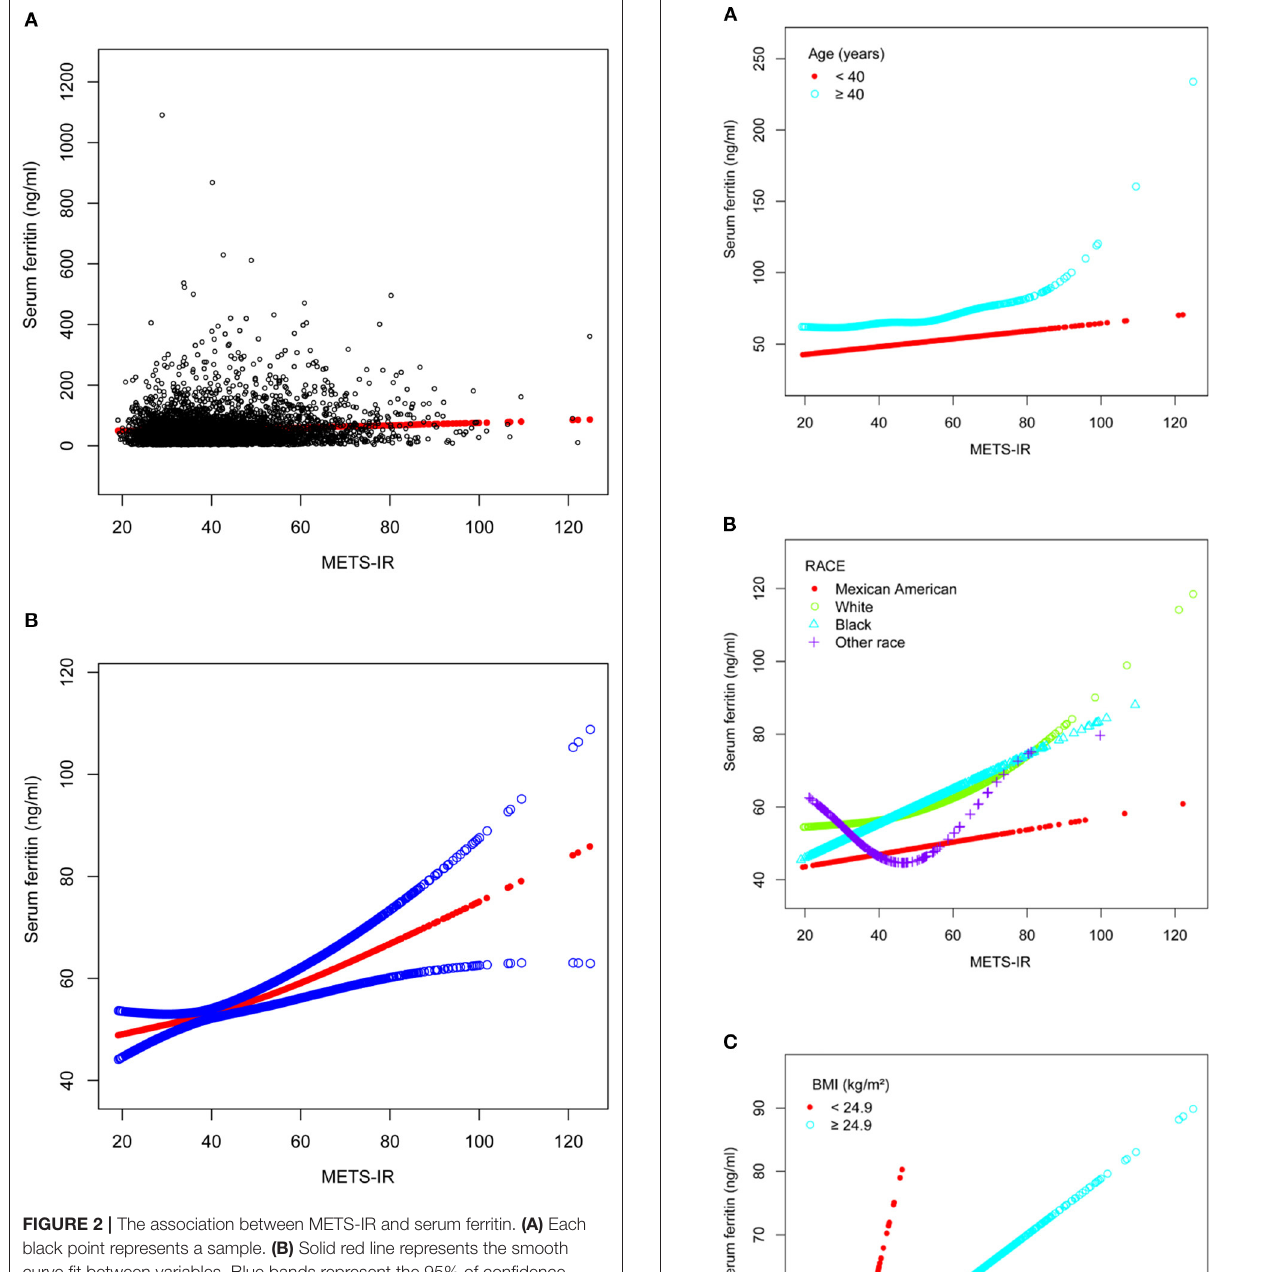
non-linear effects model in the white race with a METS- IR inflection point of 67.84 ( β = 1.13, 95% CI: 0.05 to 2.22) ( Table 4 ). The positive association between METS-IR and serum ferritin in the previous subgroup analysis was not statistically significant in participants with BMI < 24.9kg/m 2 , but this positive association remained statistically different when METS-IR exceeded 35.84 ( β = 4.61, 95% CI: 0.42 to 8.80) ( Table 5 ).